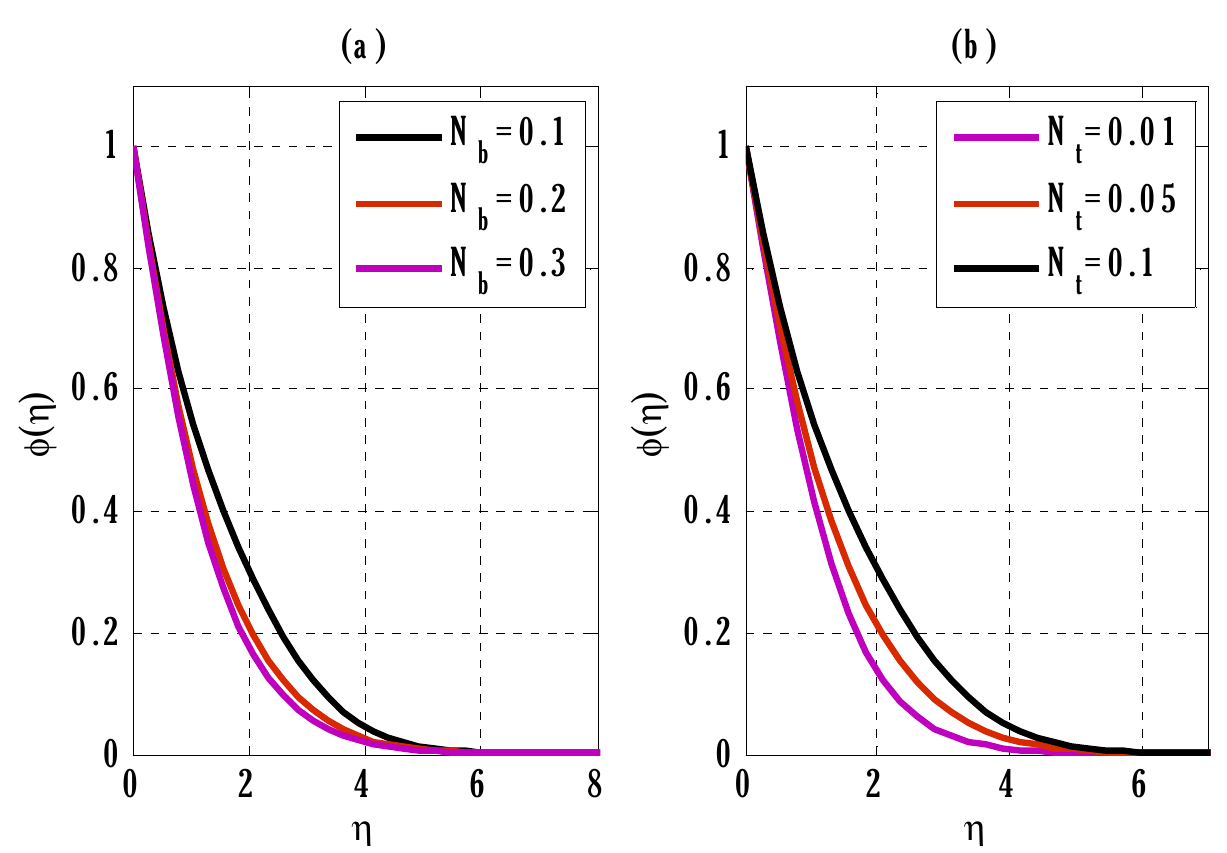
Figure 7. Variation of Brownian motion and thermophoresis parameters on concentration profile using β = 3, M = 0.1, λ = 0.1, F r = 0.1, γ = 0.1, S c = 1.5, ε 2 = 0.5, E c = 0.4, E 1 = 0.01, ε 1 = 0.9, P r = 1.7, R d = 0.1. ( a ) N t = 0.1 ( b ) N b =